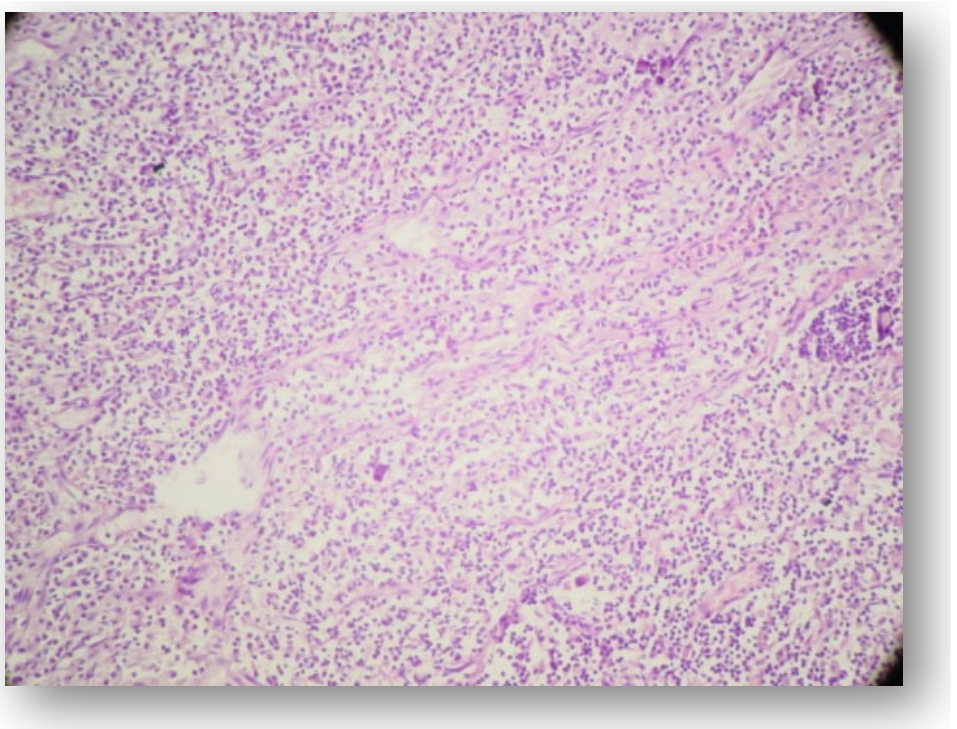
Figure 5. Dental pulp aspect (coronal pulp) of a 57 year old female, type 2 diabetes, HE staining, × 100.